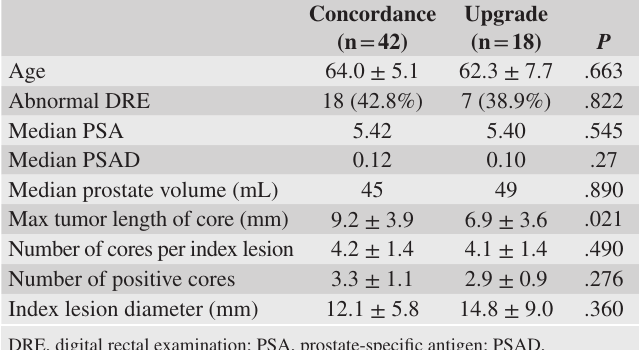
Table 5. Univariate Analysis of Possible Predictors for Concordance and Upgrade in IB-TB